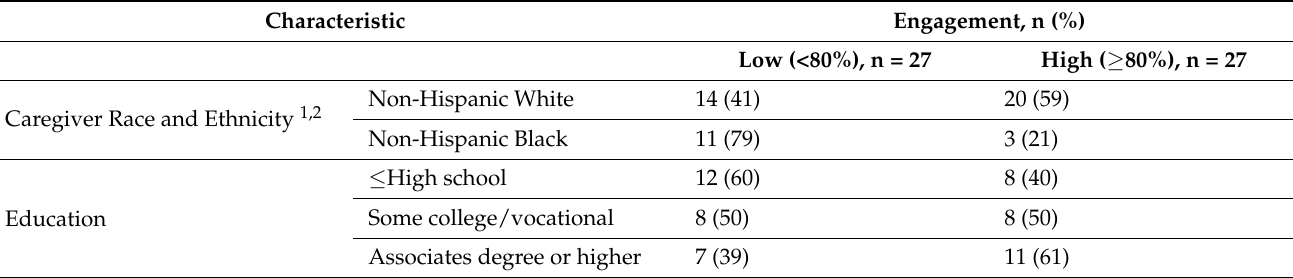
Table 3. Levels of engagement by sociodemographic characteristics (n =